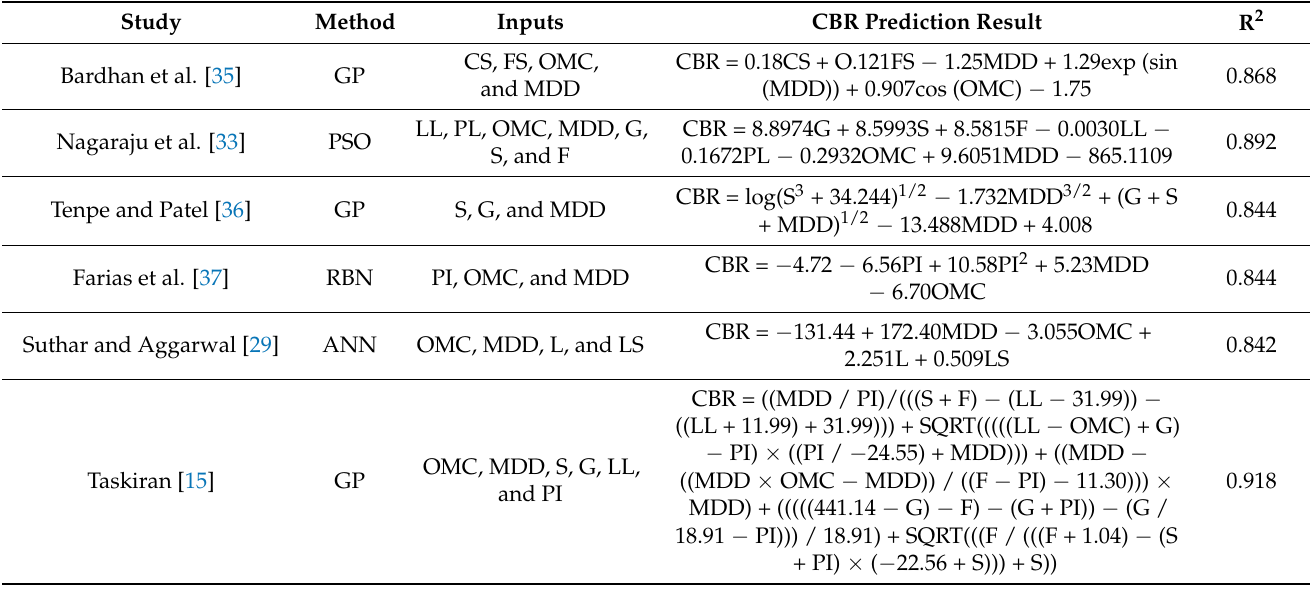
Table 1. Summary of CBR prediction models performance using